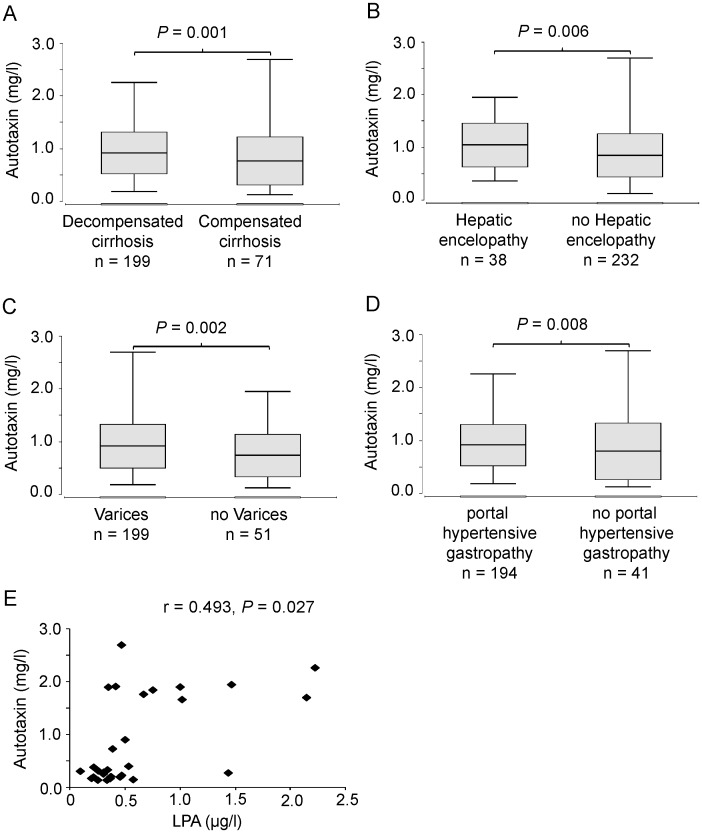
Serum autotaxin levels are higher in patients with decompensated disease and distinct complications of liver cirrhosis as compared to patients without complications.Patients with decompensated cirrhosis (A), hepatic encephalopathy (B), esophageal varices (C) and portal hypertensive gastropathy (D) show higher serum autotaxin levels. P values referring to differences between the groups were calculated with the Wilcoxon-Mann-Whitney test. (E) Correlation between LPA levels and ATX serum levels in patients with liver cirrhosis. The correlation coefficient was calculated by the Spearman test.